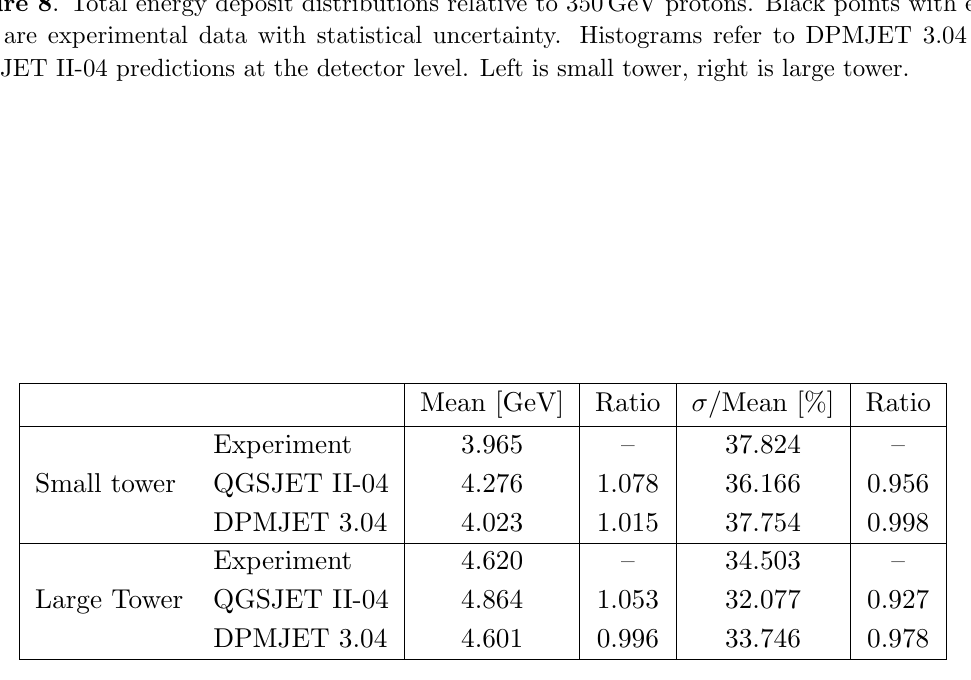
Table 5 . Energy mean and energy resolution for distributions shown in (cid:12)gure 8. For each param- eter, the ratio of model prediction to the experimental value is also